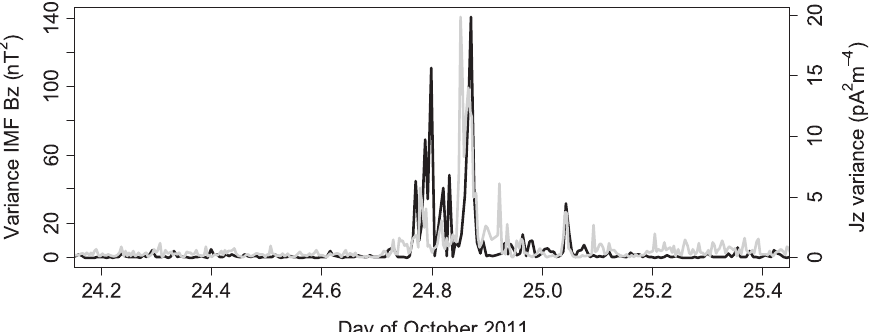
Figure 5. Time series of variance in J z (5-min values) (gray line) from MR on 24th and 25th October 2011, plotted alongside variance in z component of interplanetary magnetic field (IMF B z ) measured by the ACE spacecraft. B z time data was corrected to account for propagation time from the location of the ACE spacecraft to Earth (using a distance of 1.5 · 10 6 km (L1 point) and the observed solar wind